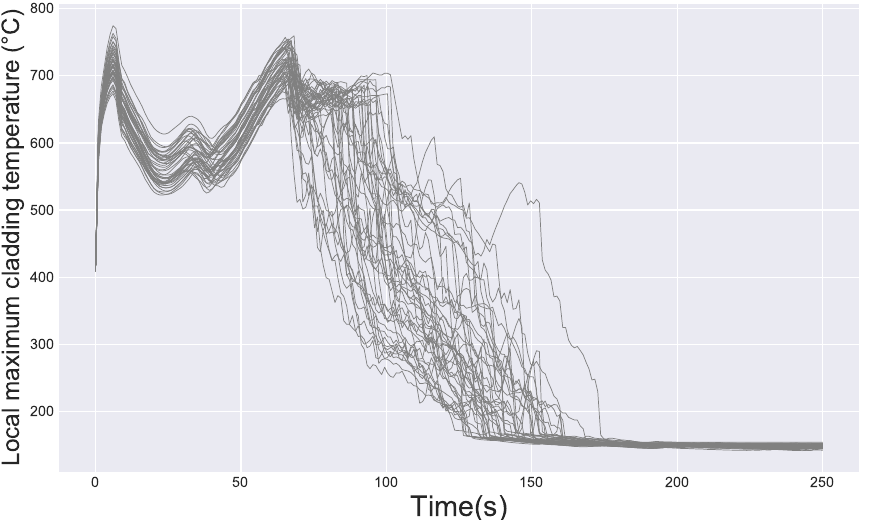
Figure 2. Examples of IBLOCA transients simulated with CATHARE2. Only 40 curves are displayed for clarity.